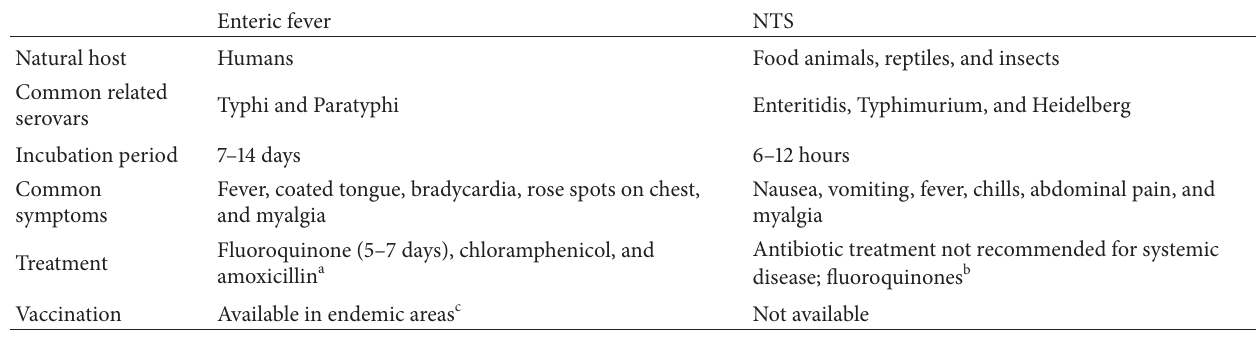
Table 7: Examples of characteristic features of enteric fever and nontyphoidal